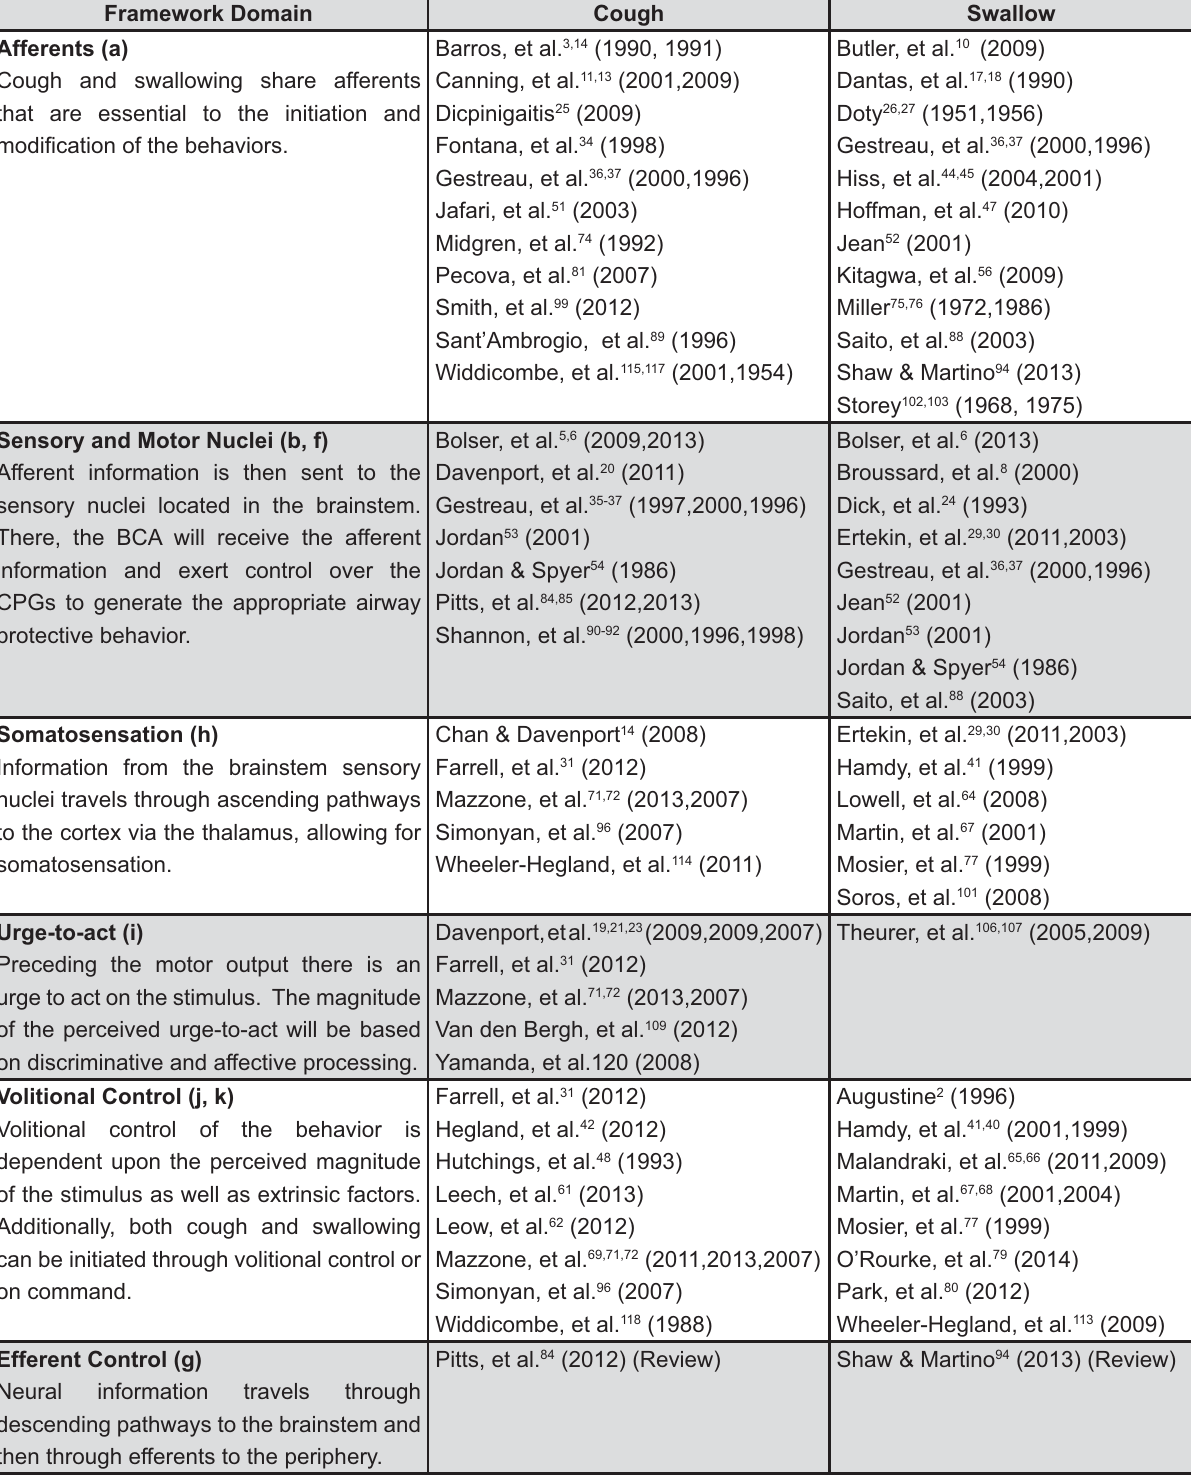
Figure 3- (cid:2)(cid:31)(cid:4)3(cid:7)(cid:12)(cid:25)3)(cid:12)(cid:7)(cid:2)(cid:27))(((cid:13)(cid:12)3(cid:4)(cid:26);(cid:2)(cid:27)(cid:6)(cid:25)(cid:12)(cid:7)+(cid:2)(cid:27))6(cid:27)3(cid:12)(cid:25)3(cid:7)(cid:27)(cid:2)(cid:13)5(cid:2)(cid:25)(cid:4)(cid:12)<(cid:25)9(cid:2)((cid:12)(cid:13)3(cid:7)(cid:5)3(cid:4)(cid:13)(cid:26)(cid:10)(cid:2)(cid:2)(cid:2)(cid:11)(cid:6)(cid:7)(cid:2)4(cid:12)(cid:27)3(cid:2)(cid:5)(cid:13)(cid:8))&(cid:26)(cid:2)((cid:12)(cid:7)(cid:27)(cid:7)(cid:26)3(cid:27)(cid:2)3(cid:6)(cid:7)(cid:2)((cid:12)(cid:13)((cid:13)(cid:27)(cid:7)+(cid:2)5(cid:12)(cid:25)&(cid:7)<(cid:13)(cid:12)=(cid:2) domain (with corresponding letter from framework Figure 2) and brief overview. The second and third columns present a representative sample of the most relevant literature supporting the framework